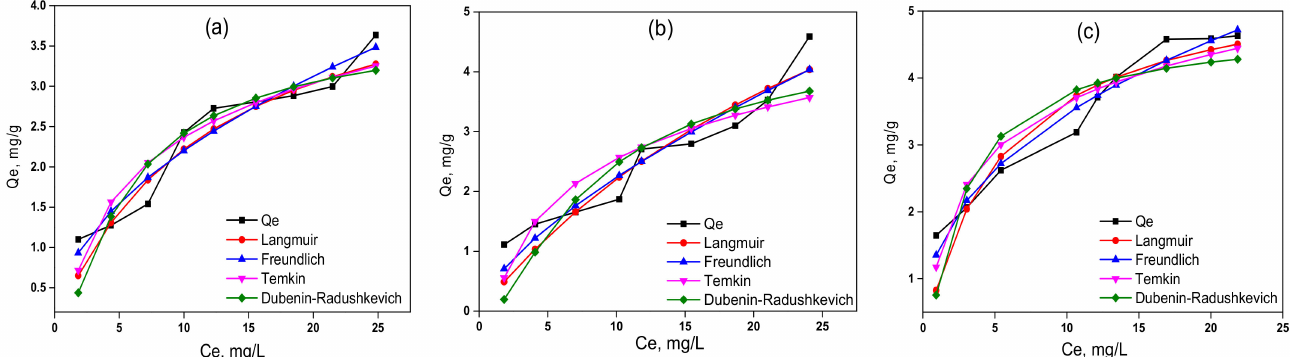
Figure 10. Adsorption isotherms of IC on ( a ) RBS, ( b ) BST1 and ( c ) BST2.